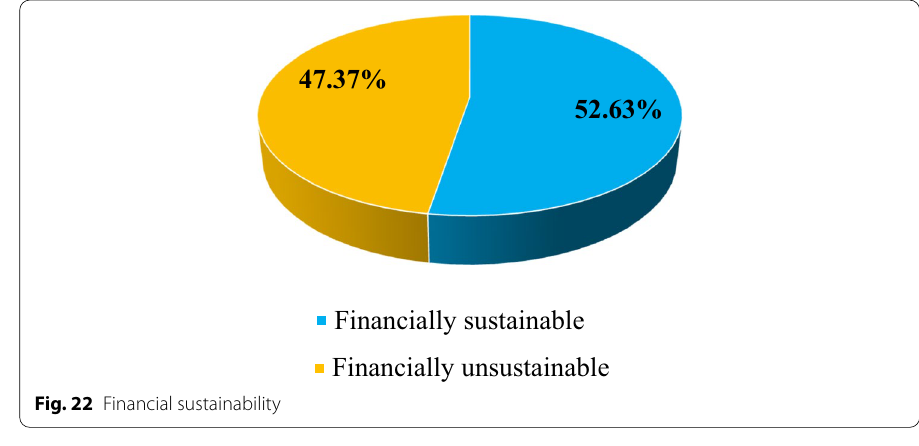
Fig. 22 Financial sustainability